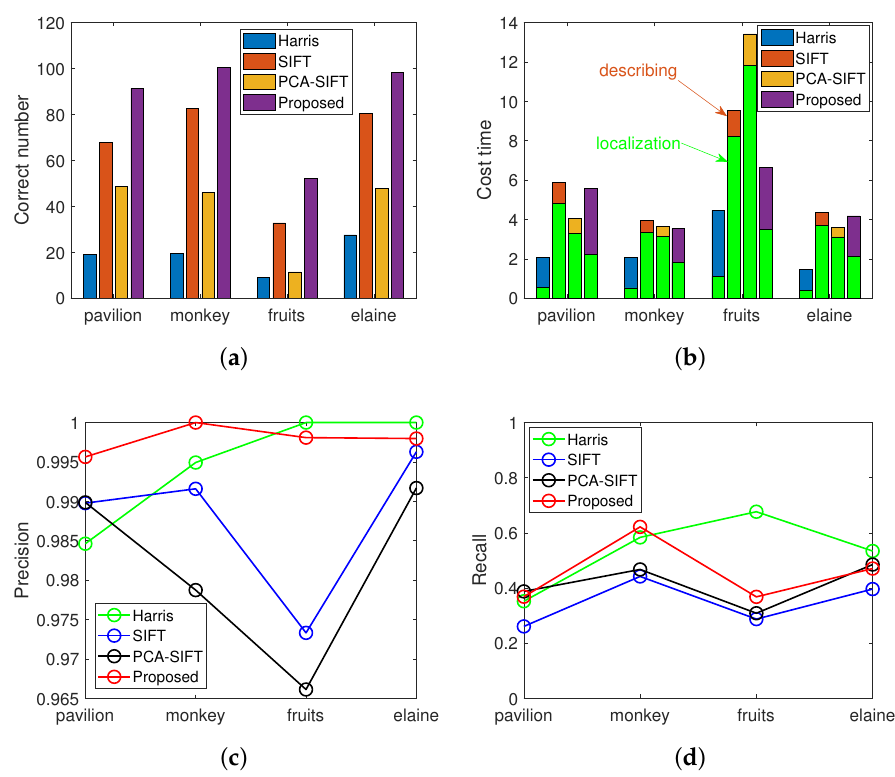
Figure 7. Results analysis of noised images matching test: ( a ) correct matching number; ( b ) cost time per match; ( c ) precision of the matches; ( d ) recall of the